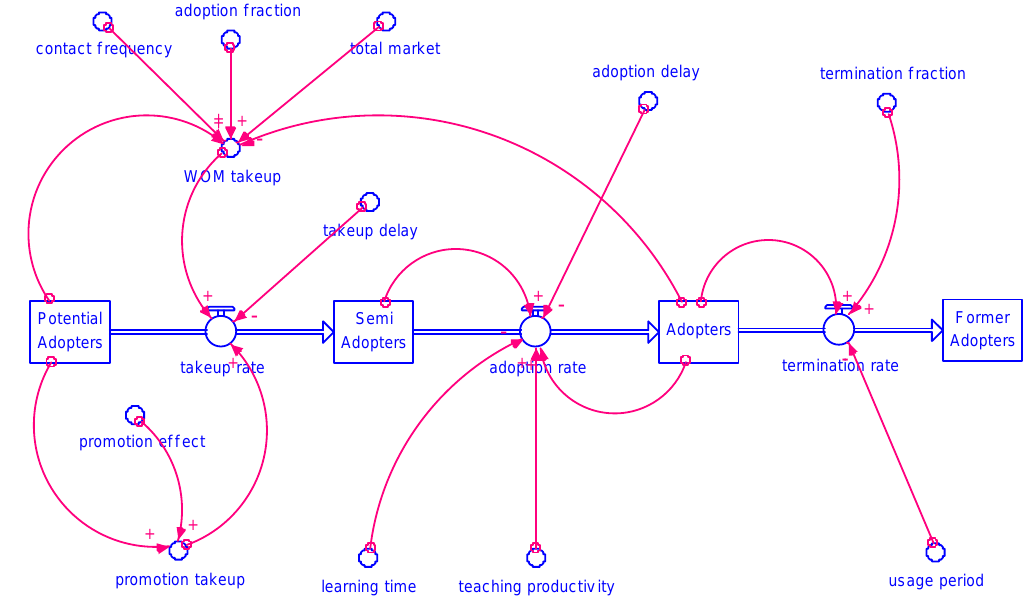
Fig. 2. System dynamics model for RET adoption (modified from Chen,